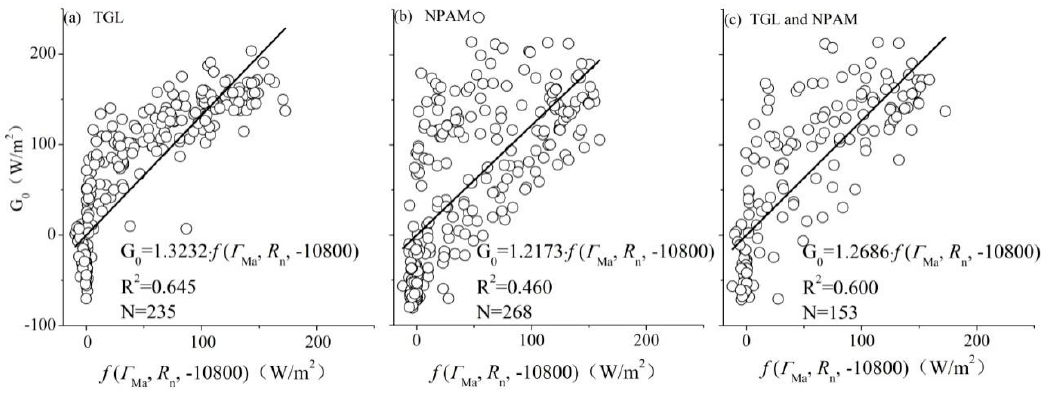
Figure A4. The coefficient a of each site when the phase shift c is equal to -10800 s (in order to ensure that the result will not be biased towards a certain site), N on graph ( c ) represents a portion of the sample data, including the same amount of data from TGL and NPAM (Table A3), not a simple combination of all of the data from the two sites).